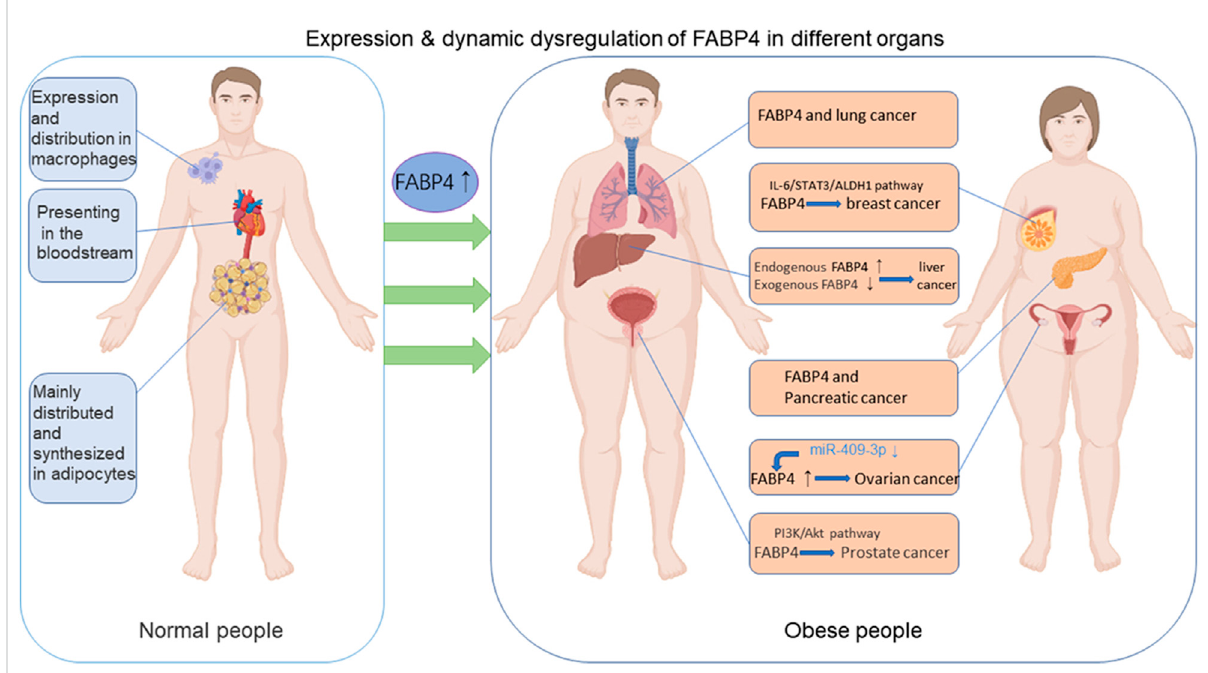
FIGURE 2 The functions ofFABP4 innormal andobese people. FABP4 issynthesizedand distributed mainly inadipocytesand macrophagesandcouldbe secreted into the blood circulation. FABP4 levels are elevated in obese individuals in comparison with normal people. FABP4 levels have been associated with carcinogenesis, including breast, ovarian, prostate, liver, pancreatic, lung cancers and so on through various pathways. (Some ofthe elements in the fi gure come from